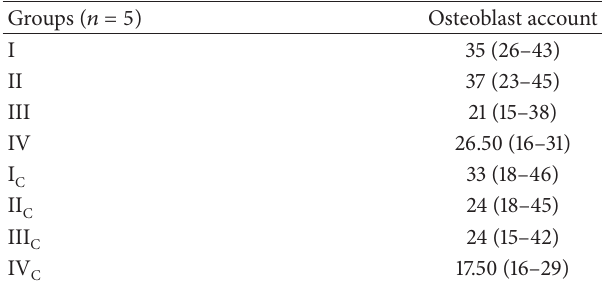
Table 3: Representation of the osteoblast account in the per-unit area (0.5 mm 2 ) of each